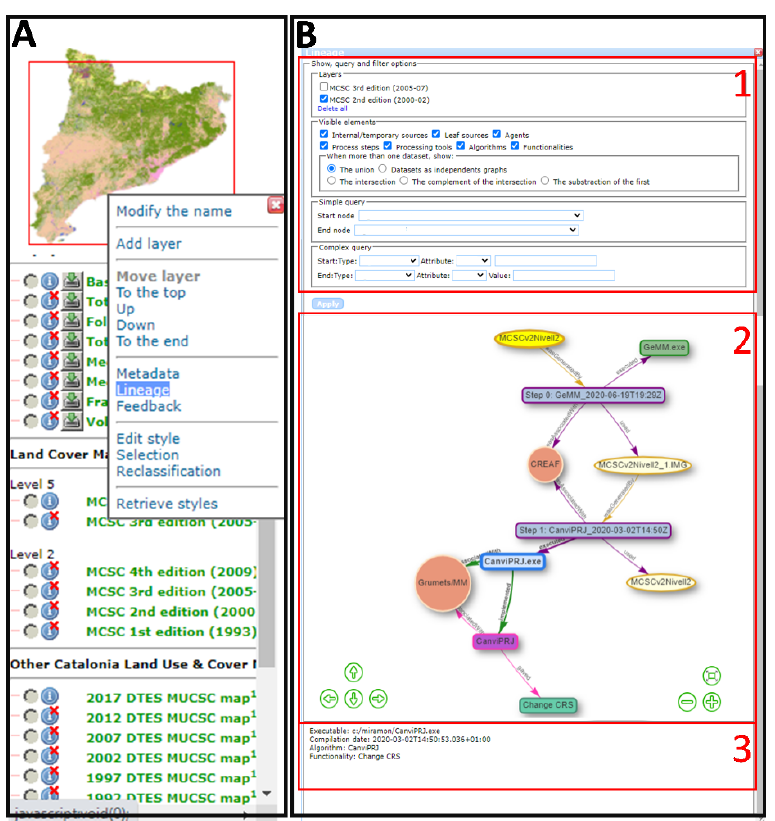
Figure 9. ( A ) Legend panel to click a layer and select Lineage. ( B ) Provenance window: 1—Visibility and query options panel (detailed in Figure 10). 2—Provenance graph panel. 3—Node attributes panel.